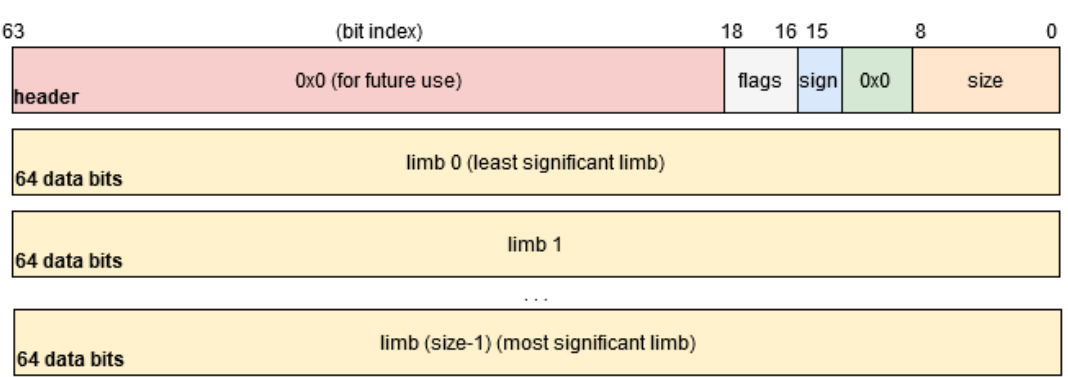
Figure 1. Architecture of Zynq-7000 SoC with implemented multiple-precision arithmetic (MPA) coprocessor.